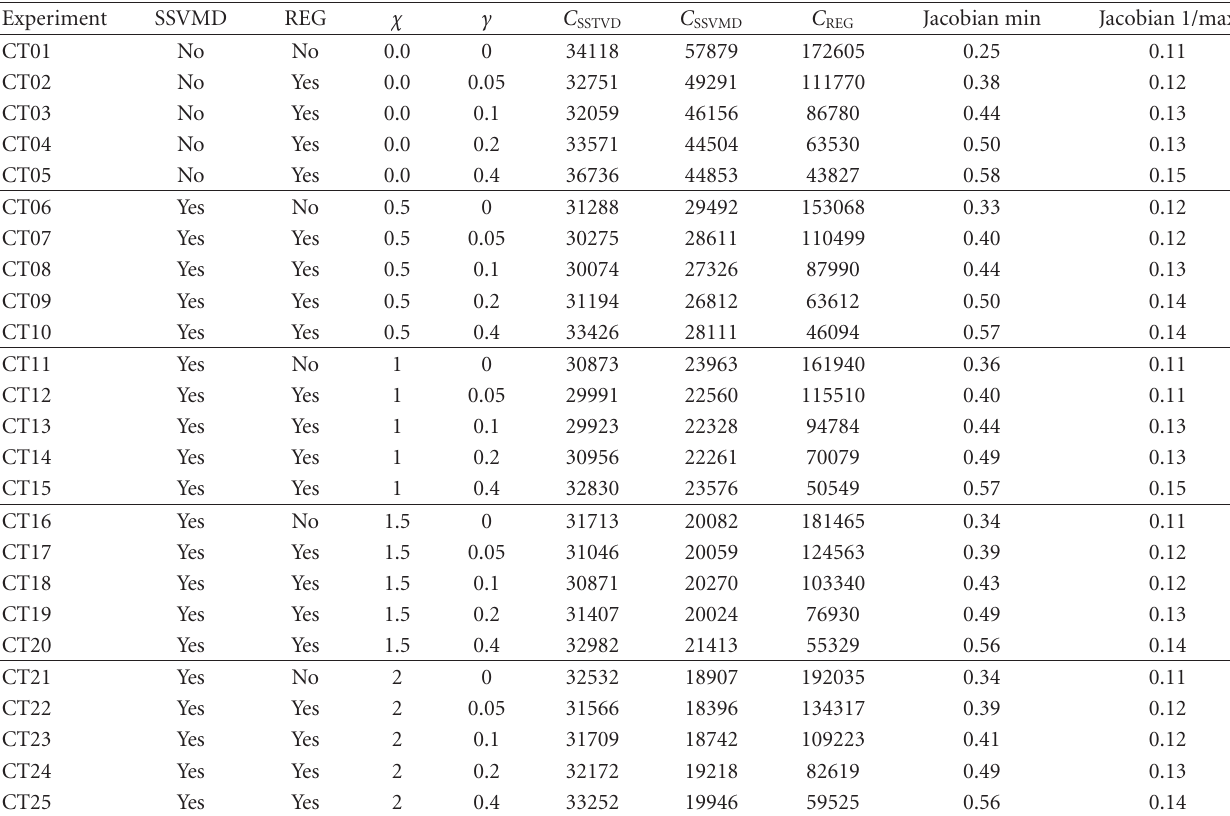
Table 1: Registration experimental parameters and cost